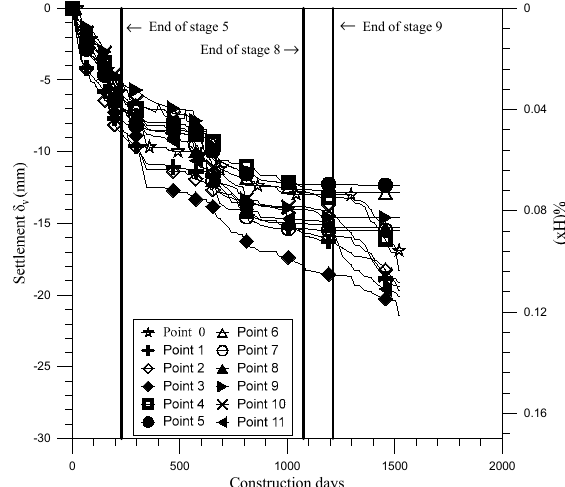
Figure 7. Settlement of points 0–11 of wall.